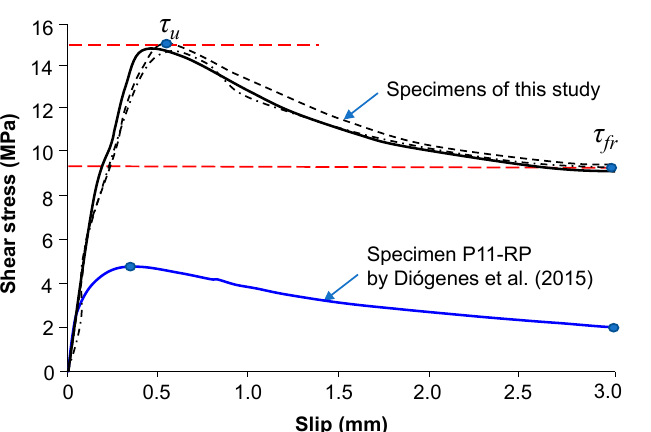
Figure 8. Comparison of shear stress–slip behaviors of the specimen tested by Diógenes et al. [11] and the ones tested in this study.